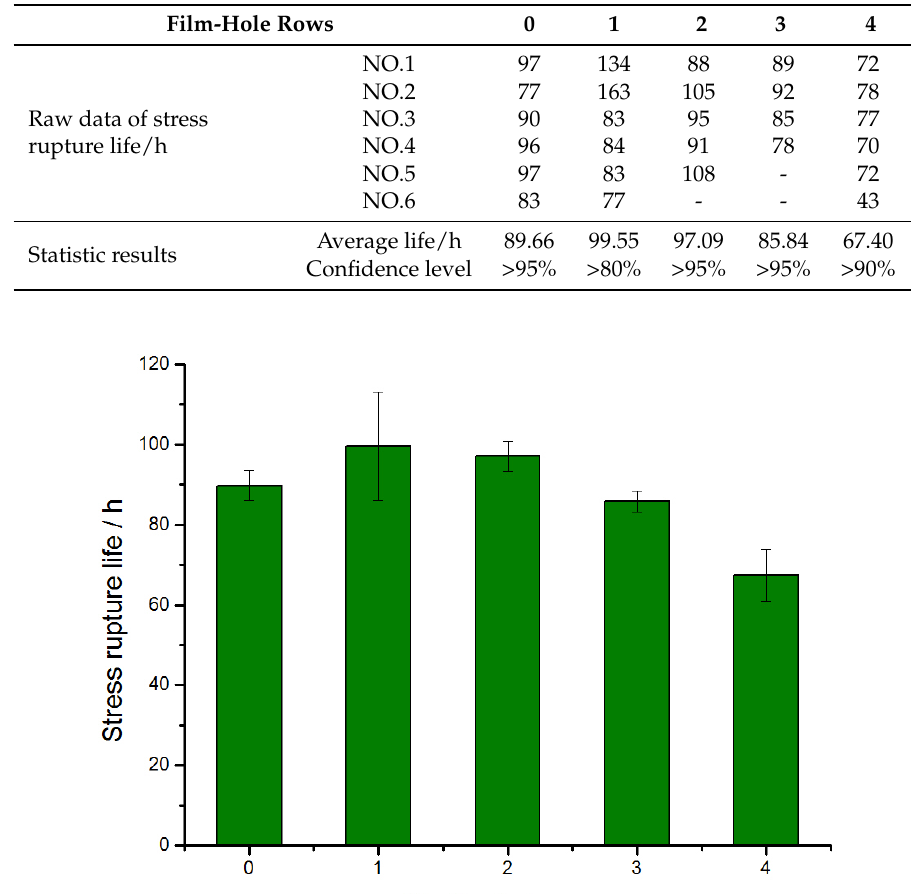
Table 2. Stress rupture test results of DD6 specimens.